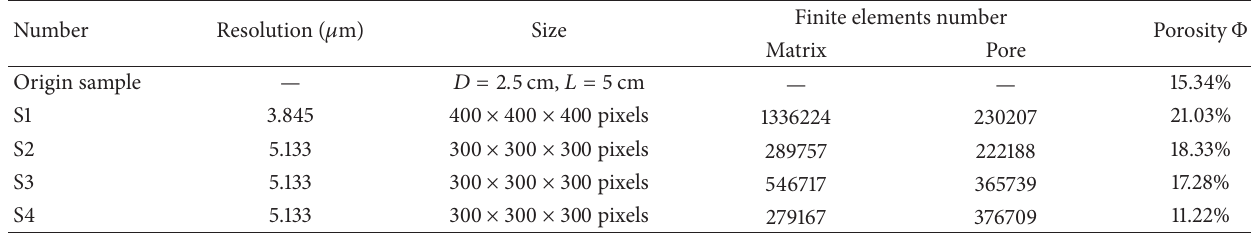
Table 1: Parameters of sandstone samples used in this